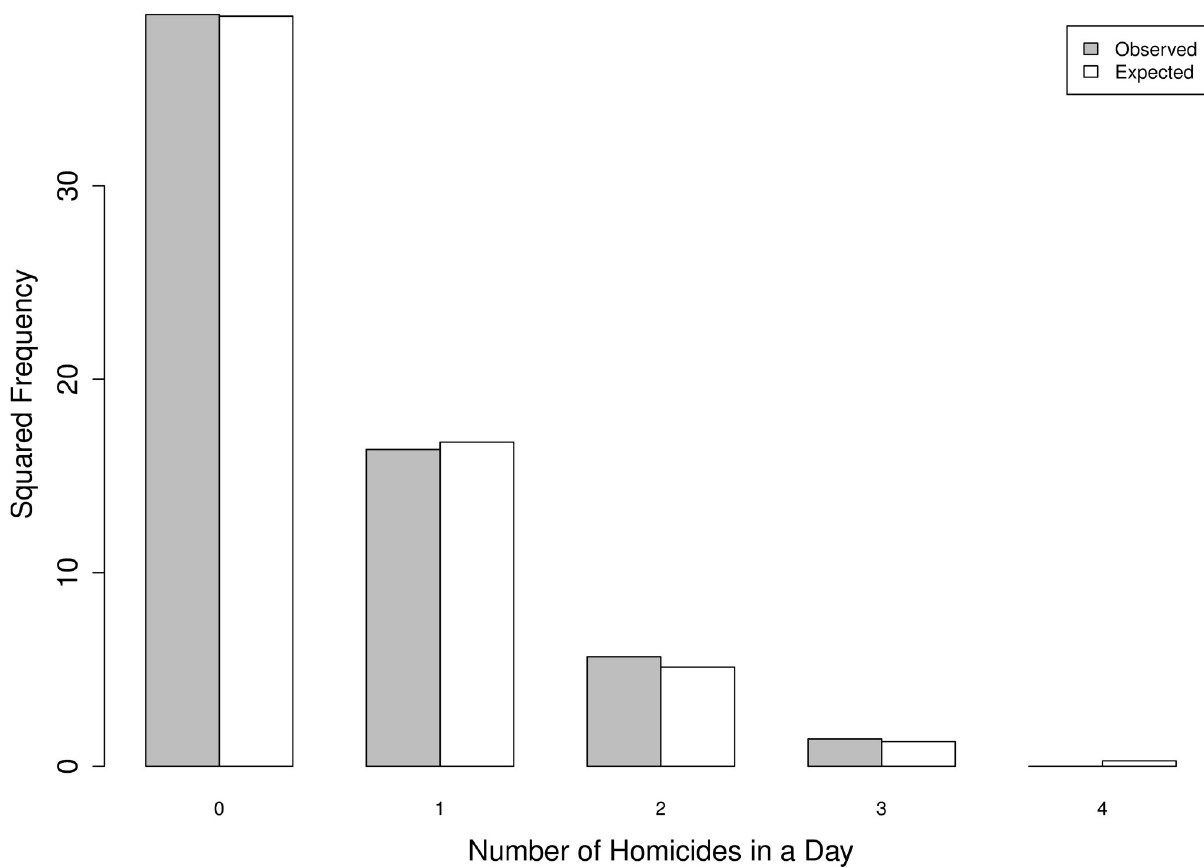
Fig 5. IPHs per day: Square root of frequencies observed (gray) and expected (white) from a Poisson process.